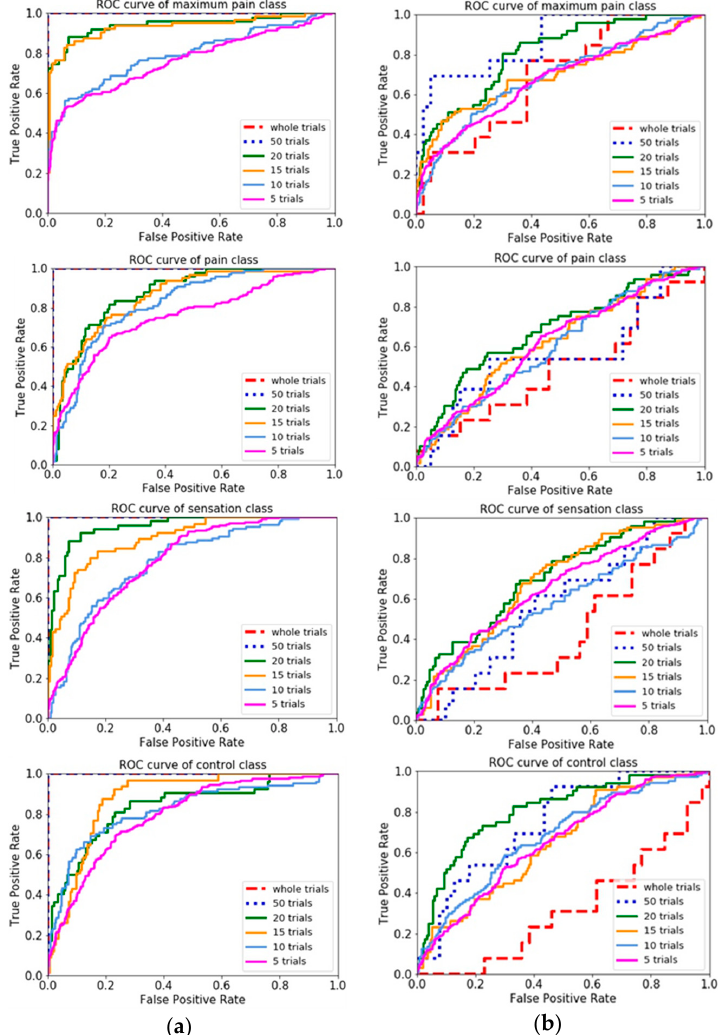
Figure 7. ROC curves of different n ‐ trial averaging for each of class in four ‐ level classification with the best and worst combined features: ( a ) Variance based group (the best combined features); ( b ) Correlation based group (the worst combined features).